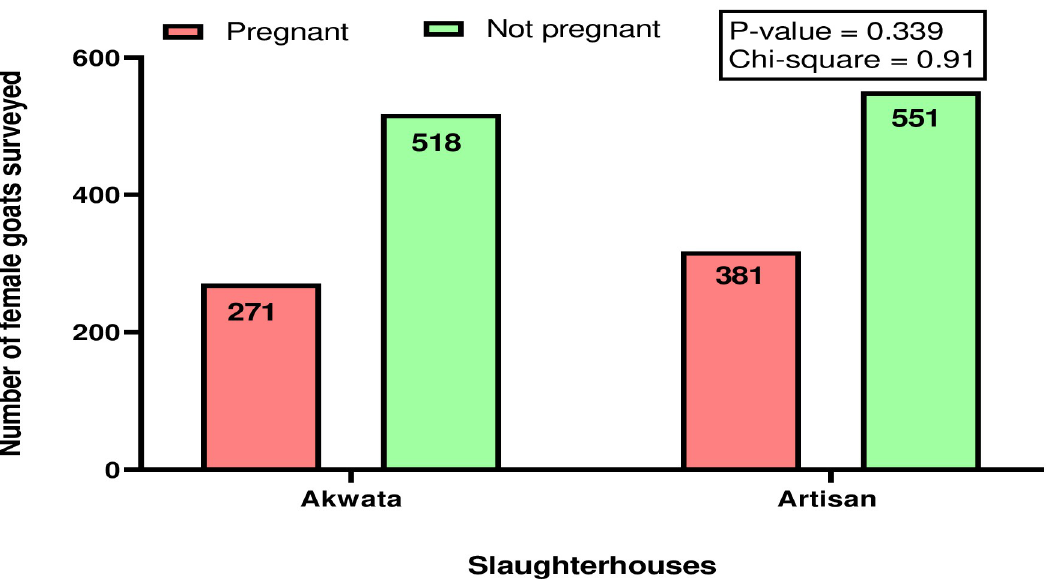
Fig 3. Pregnancy statuses of female goats (n = 1658) slaughtered for meat at Akwata (n = 789) and Artisan (n = 869) slaughterhouses in Enugu, Nigeria.